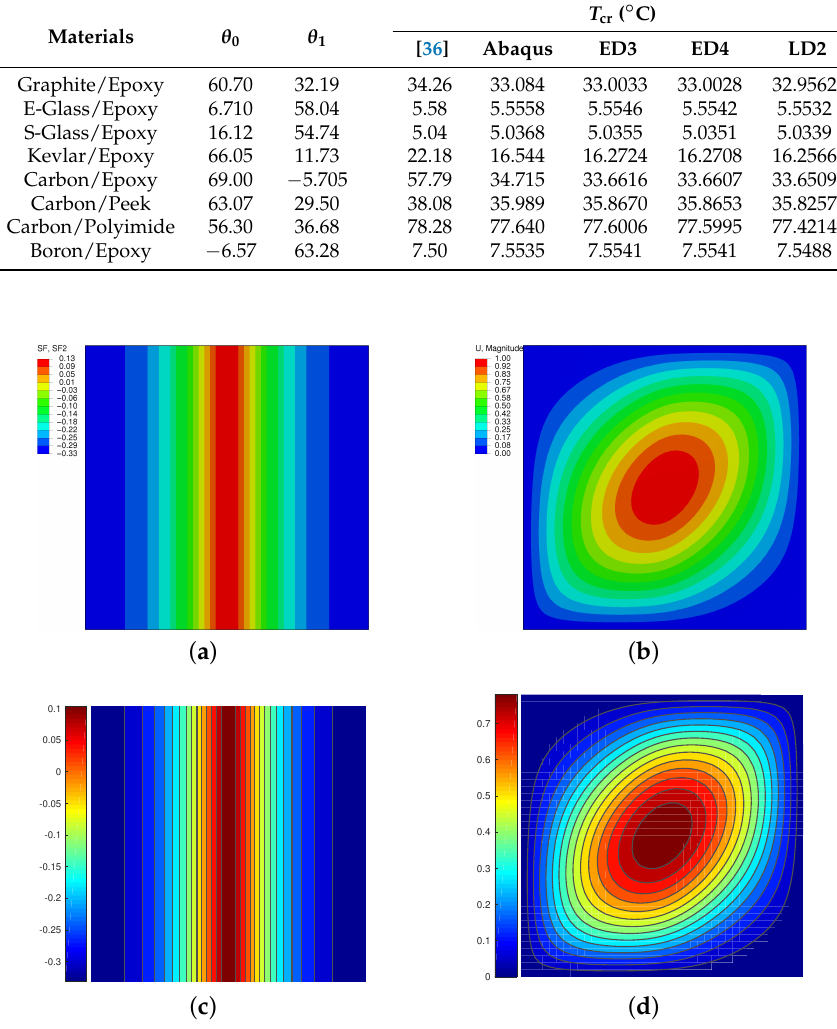
Figure 4. Kevlar/Epoxy plate: ( a ) N yy distribution (Abaqus); ( b ) buckled configuration (Abaqus); ( c ) N yy distribution (exact; used in Ritz analysis); ( d ) buckled configuration